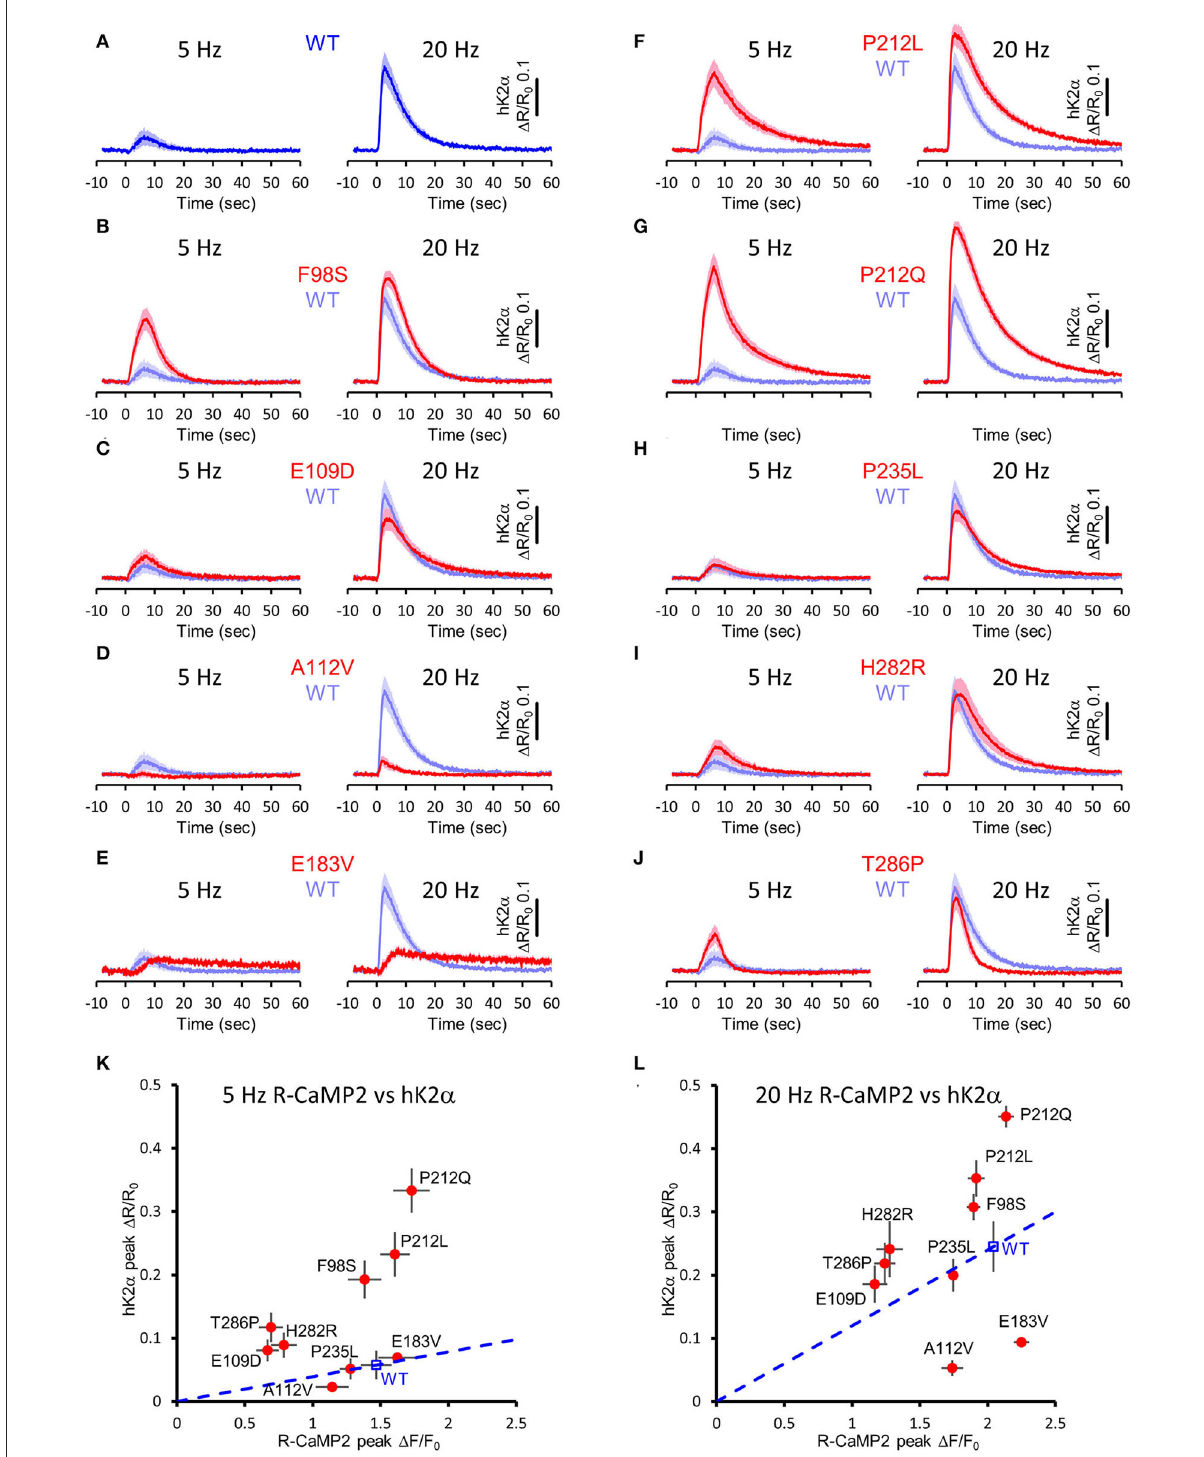
FIGURE7 Activation profiles of CAMK2A de novo mutations associated with ID in living neurons. (A–J) hK2 α activation traces in response to 30 photo-stimulations delivered at 5Hz (left) or 20Hz (right) To aid comparison, WT response traces (shaded blue traces) are overlayed in each mutant traces [red traces, (B–J) ]. Mean ± s.e.m. are shown. n = 14 for E183V and H282R, n = 15 for WT, E109D, and T286P, n = 16 for F98S, A112V, P212L, P212Q, and P235L. (K,L) R-CaMP2 peak amplitude vs. hK2 α peak amplitude plots. Mean ± s.e.m. are